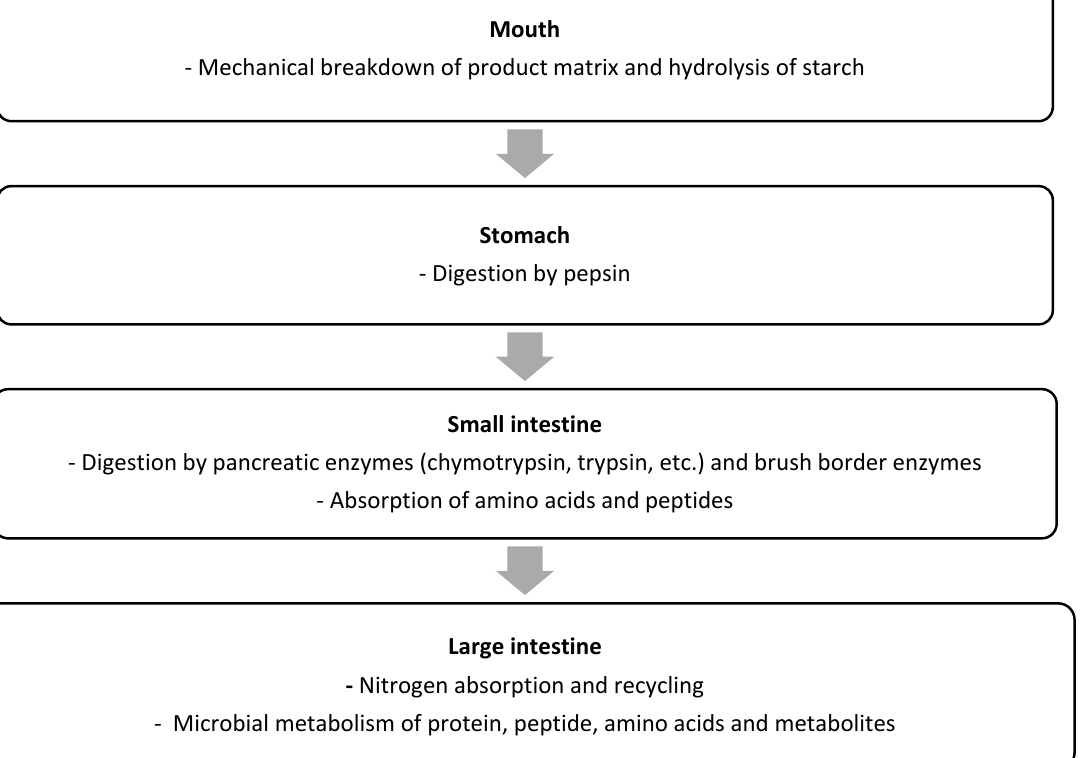
Figure 1. Schematic overview of the key steps of protein digestion and absorption in humans.